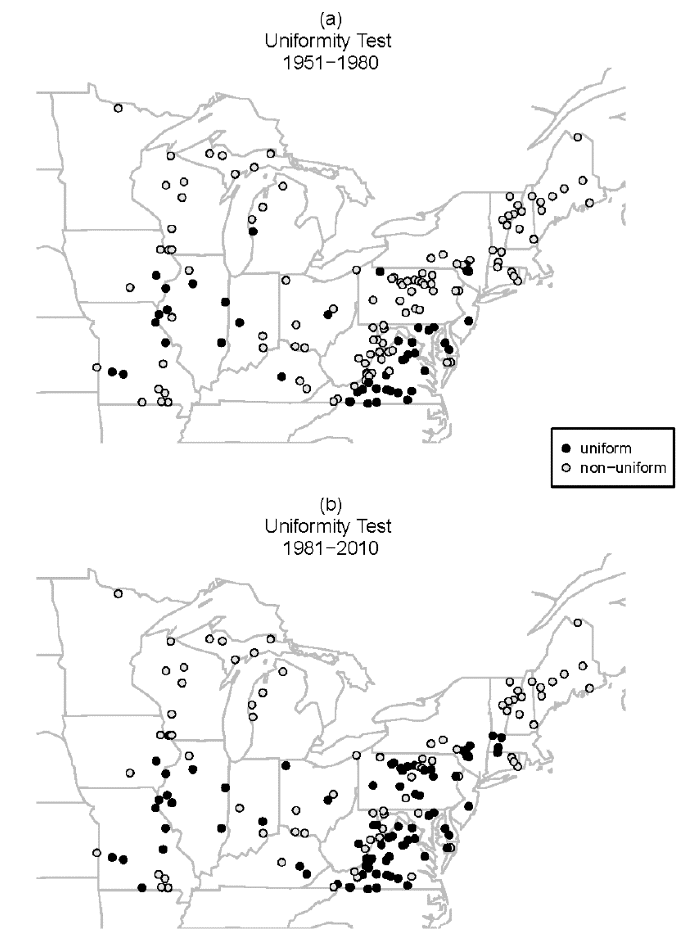
Figure 4. Spatial patterns of Rao spacing test results; a nonparametric statistical test to check the null hypothesis of uniformity of AMF dates for the periods; ( a ) 1951–1980; ( b ) 1981–2010.